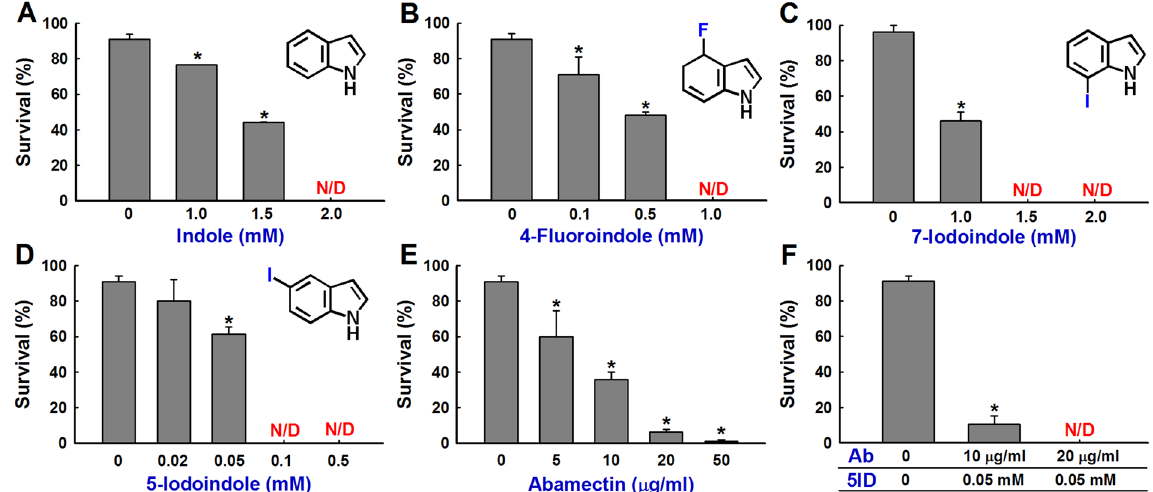
Figure 1. Nematicidal effects of indoles and abamectin on B . xylophilus survival. Dose dependent effects of ( A ) indole, ( B ) 4-fluoroindole, ( C ) 7-iodoindole, ( D ) 5-iodoindole, and ( E ) abamectin on the survival of B . xylophilus . ( F ) Effect of 5-iodoindole in combination with abamectin on B . xylophilus survival. Ab indicates abamectin and 5ID indicates 5-iodoindole. The graph shows the means ± SEMs of three repetitions. * P < 0.05 vs. the non-treated control; and N/D indicates not